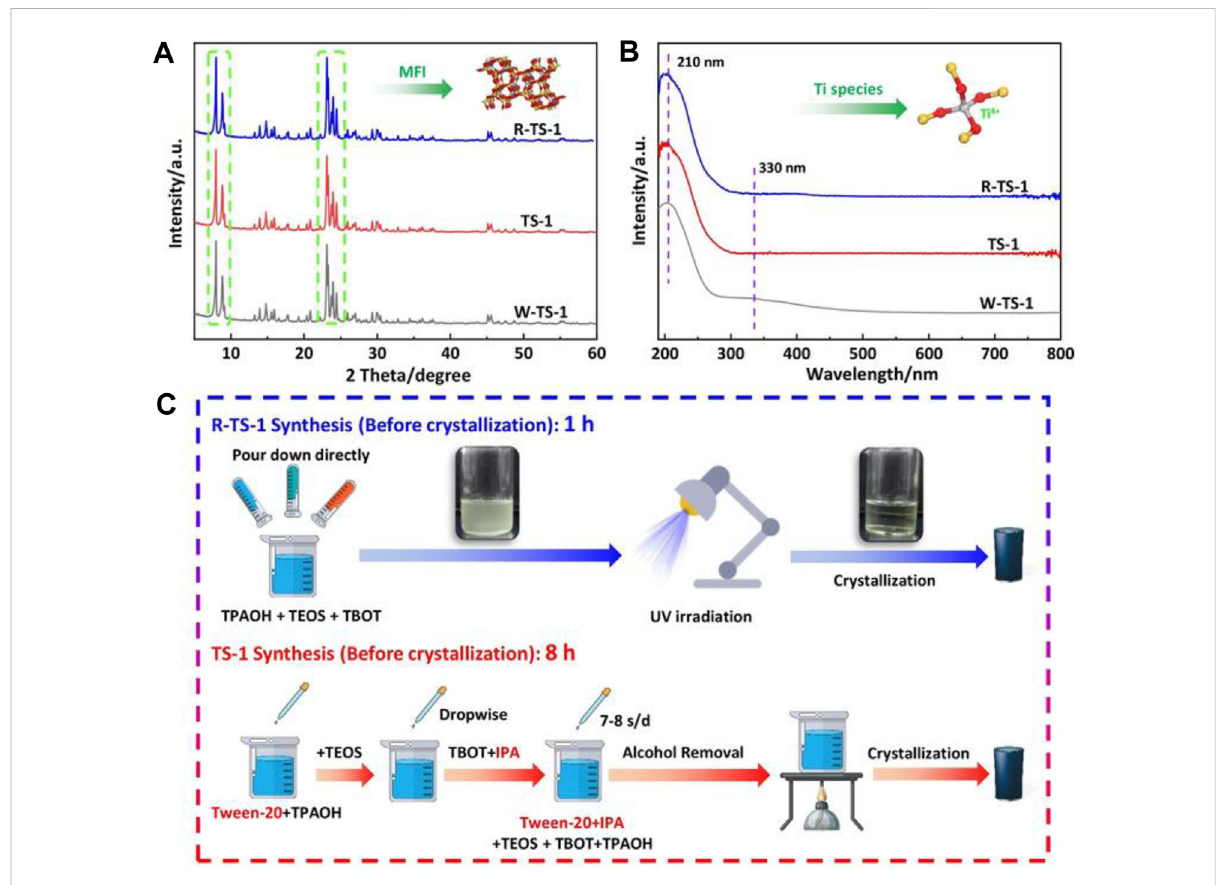
FIGURE 3 (A) XRD patterns and (B) UV spectra of R-TS-1 (with UV irradiation and without additives), TS-1 (with additives), and W-TS-1 (without UV irradiation and additives). (C) Representation of the synthetic procedures. Reprinted with permission from Lin et al. (2021). Copyright 2020 Wiley- VCH